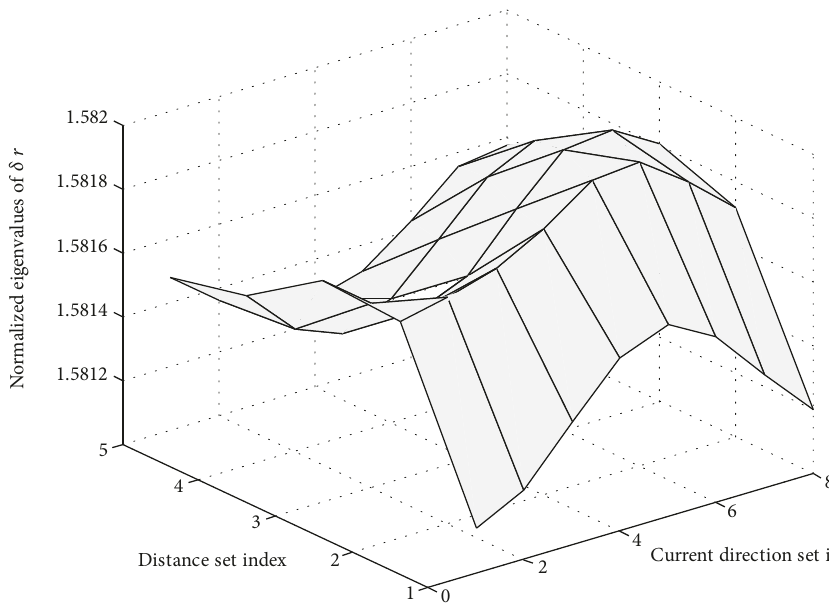
Figure 12: Normalized eigenvalues of the linear distance error between the AUV and the beacon under di ff erent current direction and distance conditions.